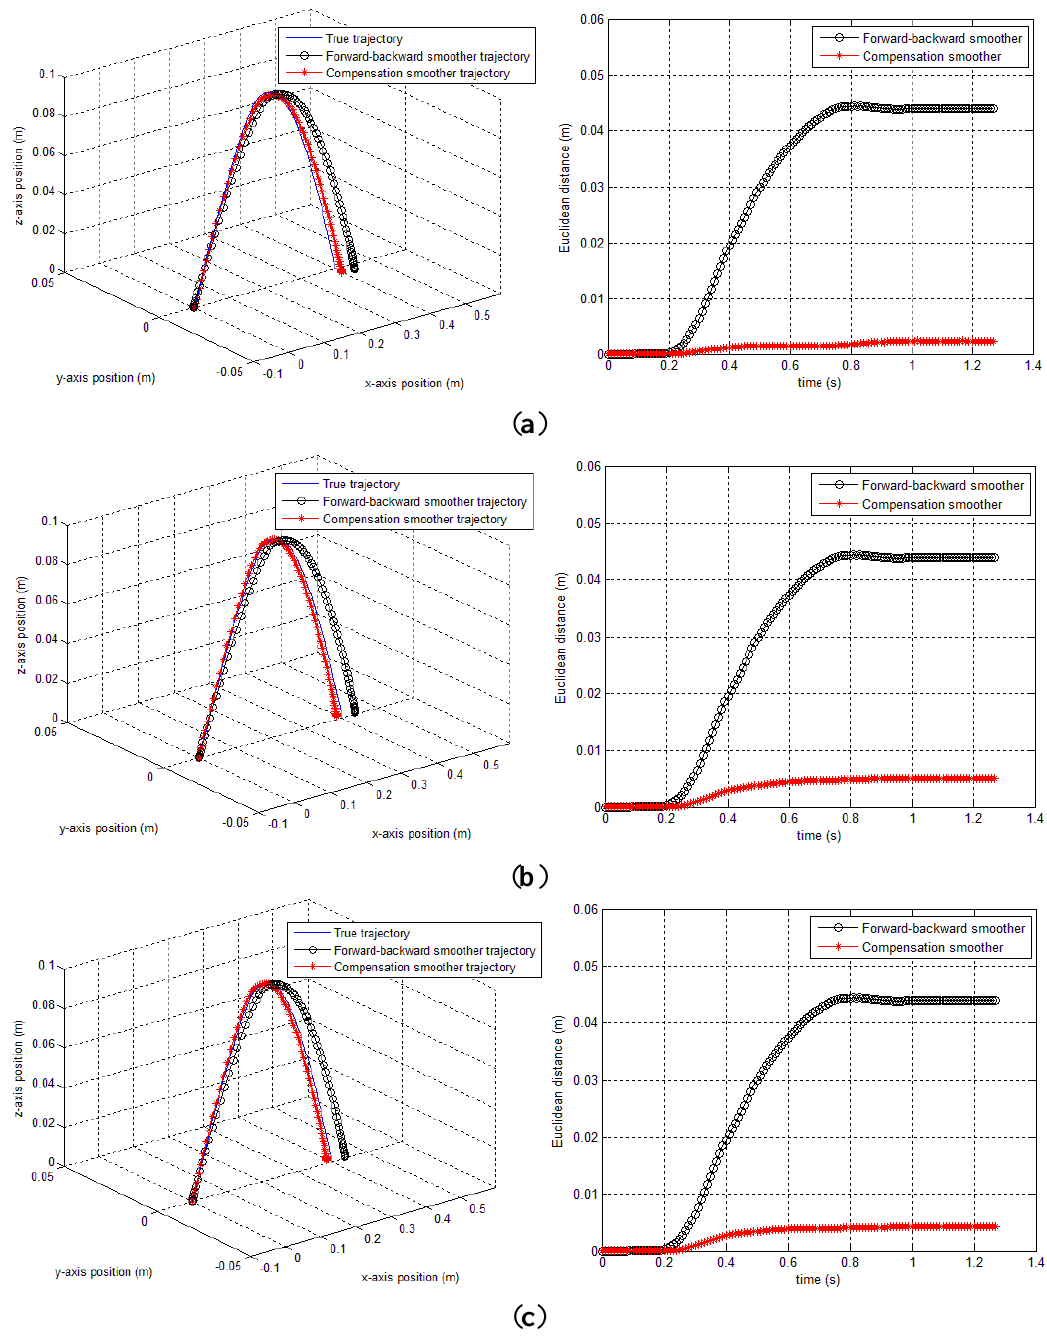
Figure 7. True and estimated trajectories. ( a ) method 1 result: 3D trajectory and Euclidean distance over time; ( b ) method 2 (triangle approximation): 3D trajectory and Euclidean distance over time; ( c ) method 2 (quadratic approximation): 3D trajectory and Euclidean distance over